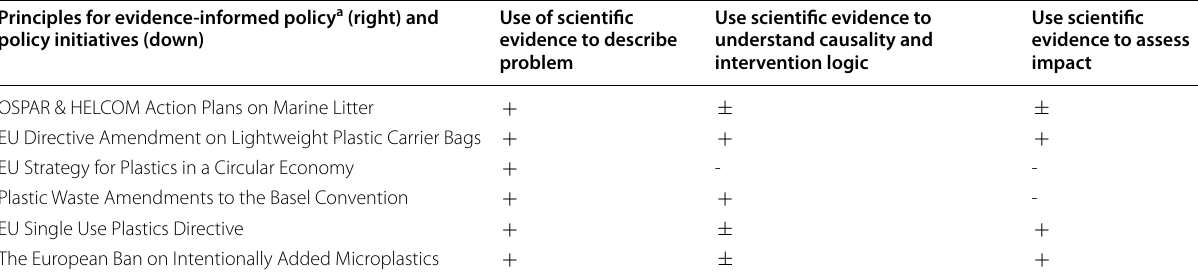
a According to the European Union’s Communication on ‘Better Regulation’ [29, 30] and ‘Better Regulation’ toolbox [38]